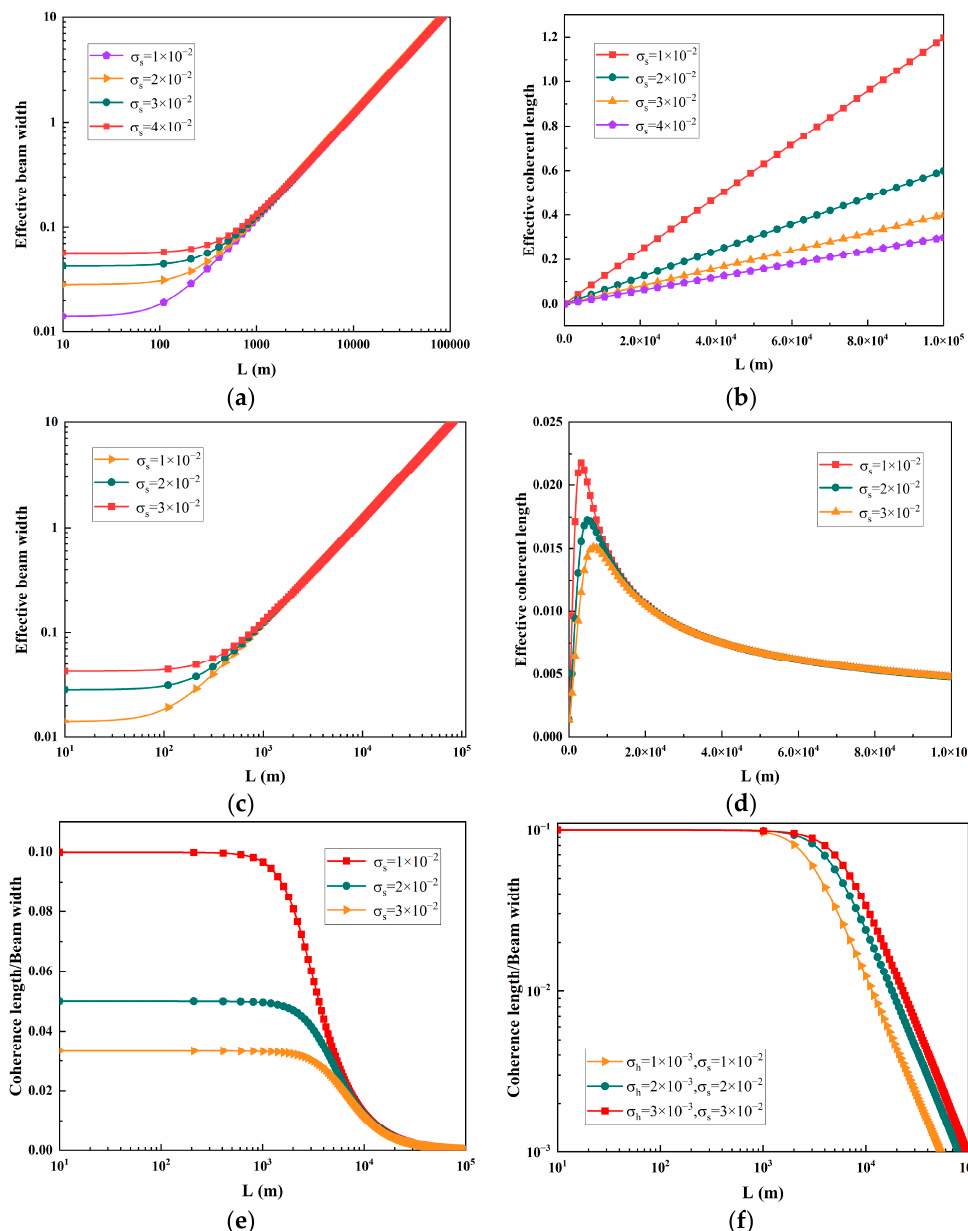
Figure 7. The in fl uence of the beam waist radius of the source beam on the e ff ective beam width. Figure 7. The influence of the beam waist radius of the source beam on the effective beam width. l = 5 × 10 − 3 m; σ l = 5 × 10 − 3 m; σ λ = 532 nm; ( a , b , e ) λ = 532 nm; ( a , b , e ) λ = 532 nm; l 0 = 5 × 10 − 3 m; σ h = 1 mm; ( c , d ), λ = 532 nm; l 0 = 5 × 10 − 3 m; σ h = 1 mm; h = 1 mm; ( c , d ), h = 1 mm; 0 0 2 C = 10 − 15 m − 2/3 ; ( f ). λ = 532 nm; C = 10 − 15 m − 2/3 . l = 5 × 10 − 3 m; 2 C 2 n = 10 − 15 m − 2/3 ; ( f ) λ = 532 nm; l 0 = 5 × 10 − 3 m; C 2 n = 10 − 15 m − 2/3 n n 0